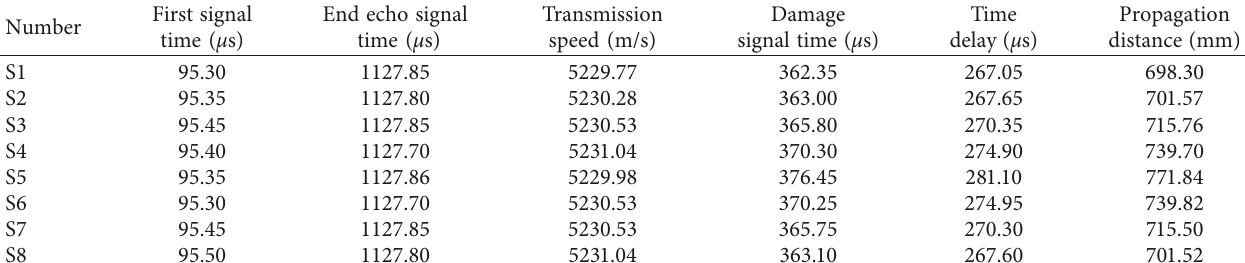
Table 3: Guide wave propagation distances between the signal receiving points and defect reflection point.